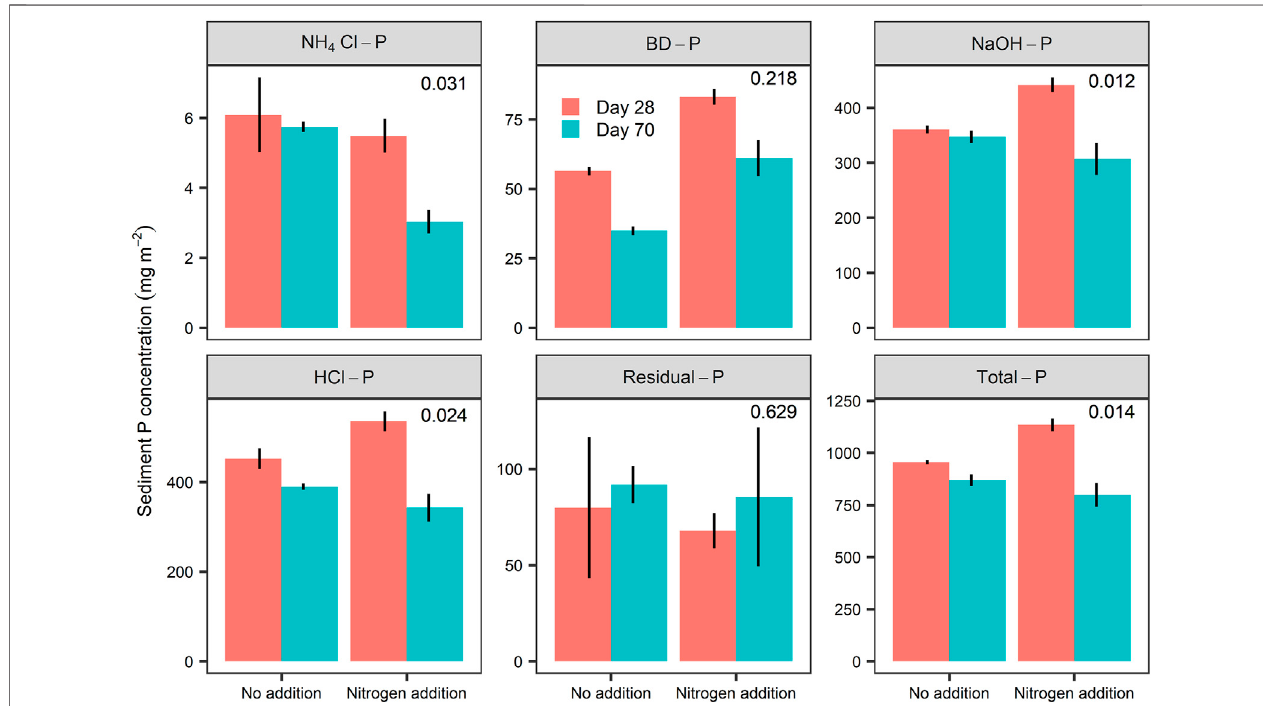
FIGURE3| SedimentPconcentrations(mgm − 2 )inthetwonitrogentreatmentscalculatedfromthedifferencesinPcontentsinthetop4 cmsedimentsbetweenthe twosamplingevents(Day28andDay70).Valuesarepresentedasmean ± SE( n (cid:2) 3).Notethattherangeofthe Y -axisdiffersamongthepanels.Thevalueineachpanelis the p value of the interaction term (days * Nitrogen). p < 0.05 indicated that the P contents between the two sampling events were different for both nitrogen treatments.